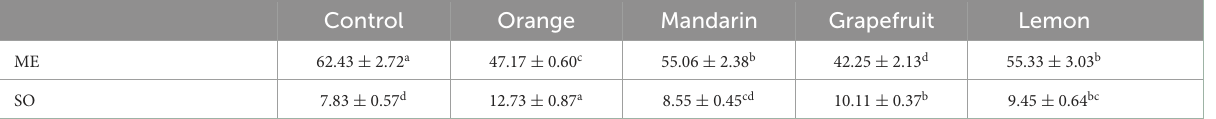
TABLE 2 Microencapsulation efficiency (ME) and surface oil (SO) of microencapsulated fish oil.